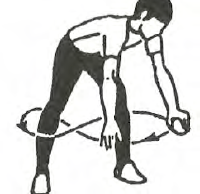
Fig. 1. Implementation of the coordination test of ten “eight” (Kopylov’s exercise).